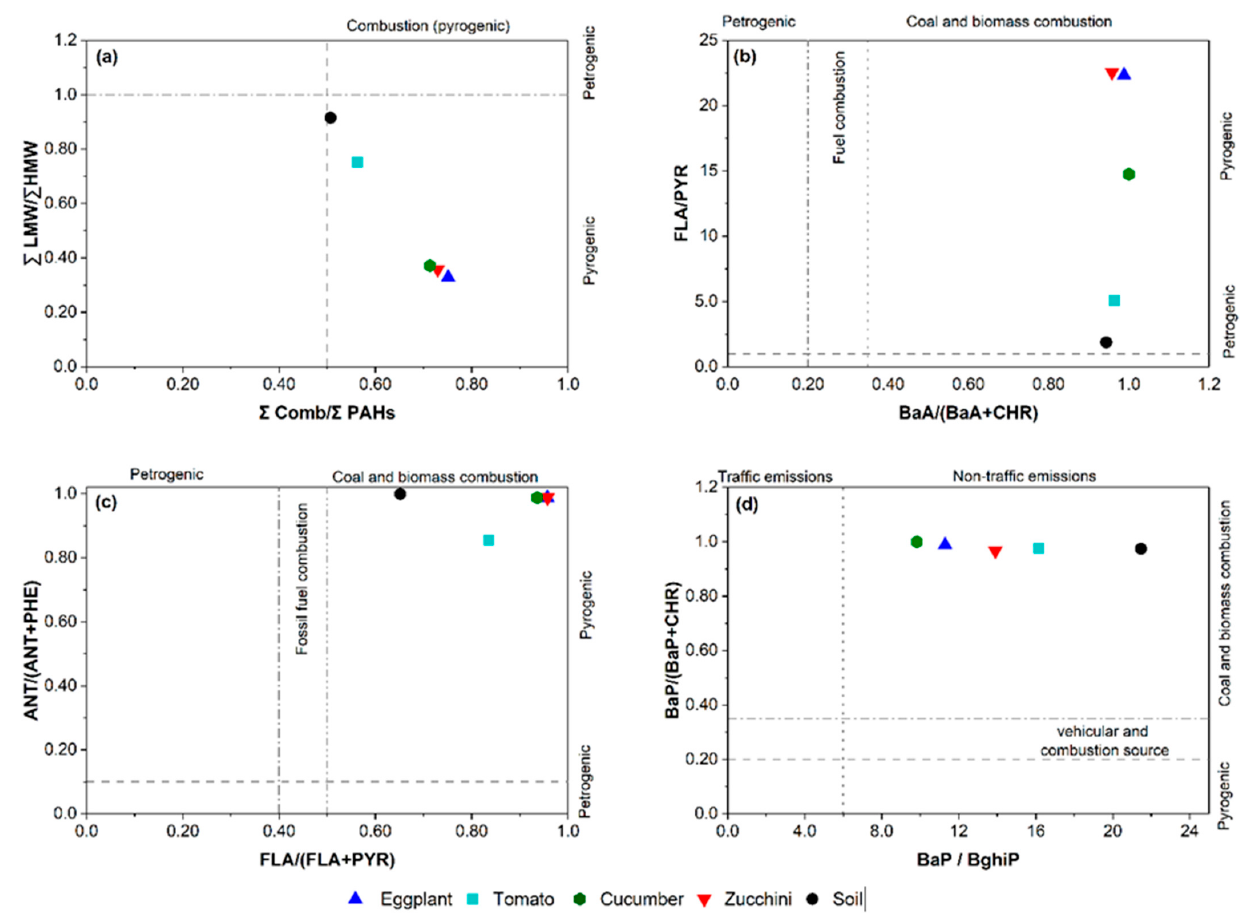
Figure 5. Cross-plots for the diagnostic ratios of: ( a ) LMW/HMW vs. ∑ comb/ ∑ 16PAHs, ( b ) BaA/(BaA+CHR) vs. (FLA/PYR), ( c ) FLA/(FLA+PYR) vs. ANT/(ANT+PHE), and ( d ) BaP/BghiP vs. BaP/(BaP+CHR) in soil and vegetables of King Talal Dam (KTD) and south of Deir Alla (SDA) in the Jordan Valley, Jordan.